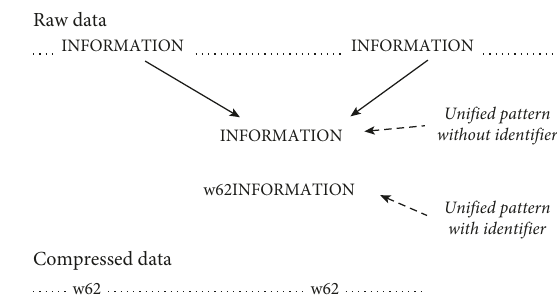
Figure 6: A schematic representation of the way two instances of the pattern “INFORMATION” in a body of data may be unified to form a single “unified pattern,” shown just above the middle of the figure. To achieve lossless compression, the relatively short iden- tifier “w62” may be assigned to the unified pattern “IN- FORMATION,” as shown below the middle of the figure. At the bottom of the figure, the original data may be compressed by replacing each instance of “INFORMATION” with a copy of the relatively short identifer, “w62” (adapted from Figure 2.3 in [5], with